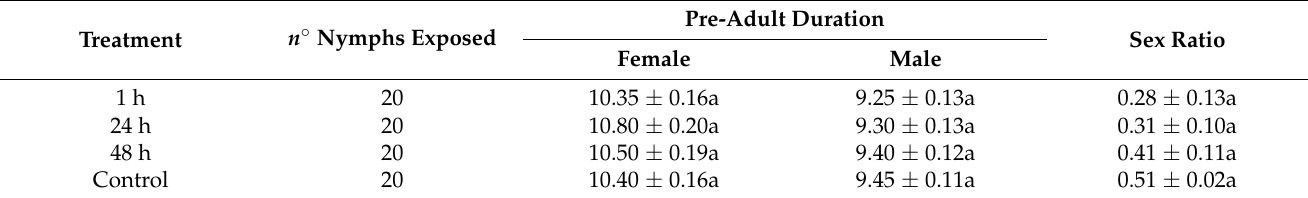
Means in the same column with the same letter are not significantly different (Tukey, p <